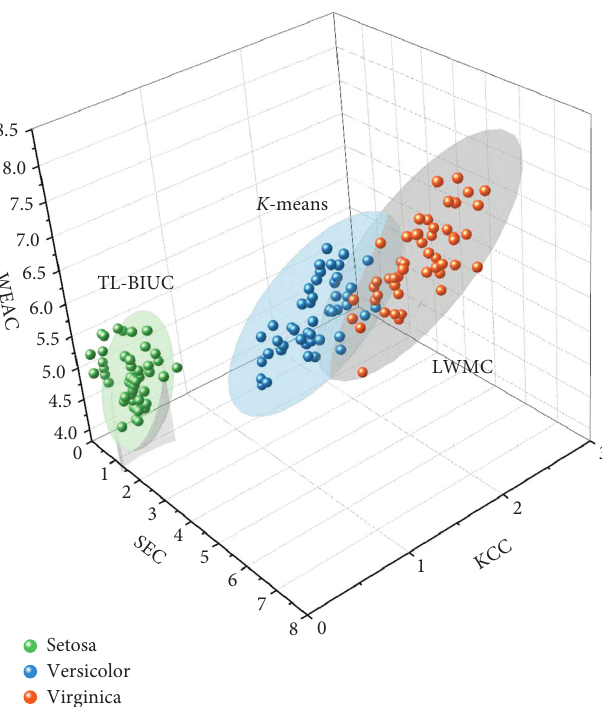
Figure 7: NMI metric performance comparison of TL-FIUC algorithm on image